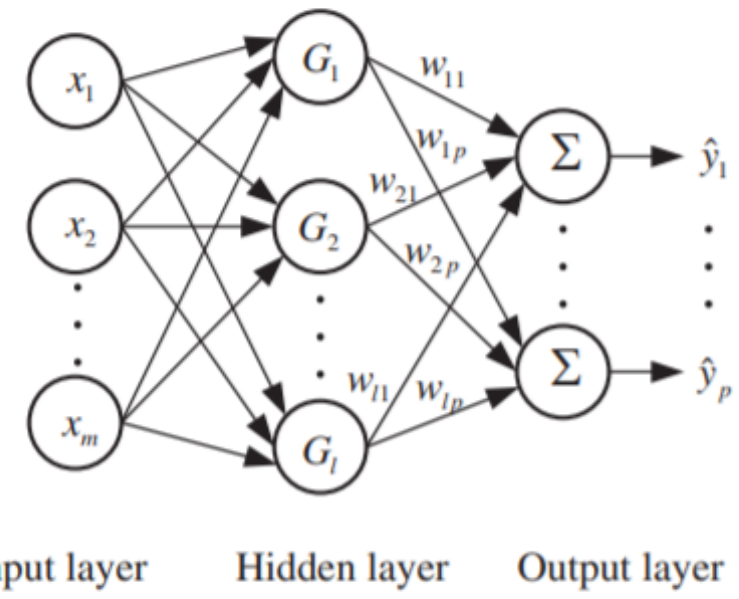
Figure 7. Architecture of RBFNN [37].